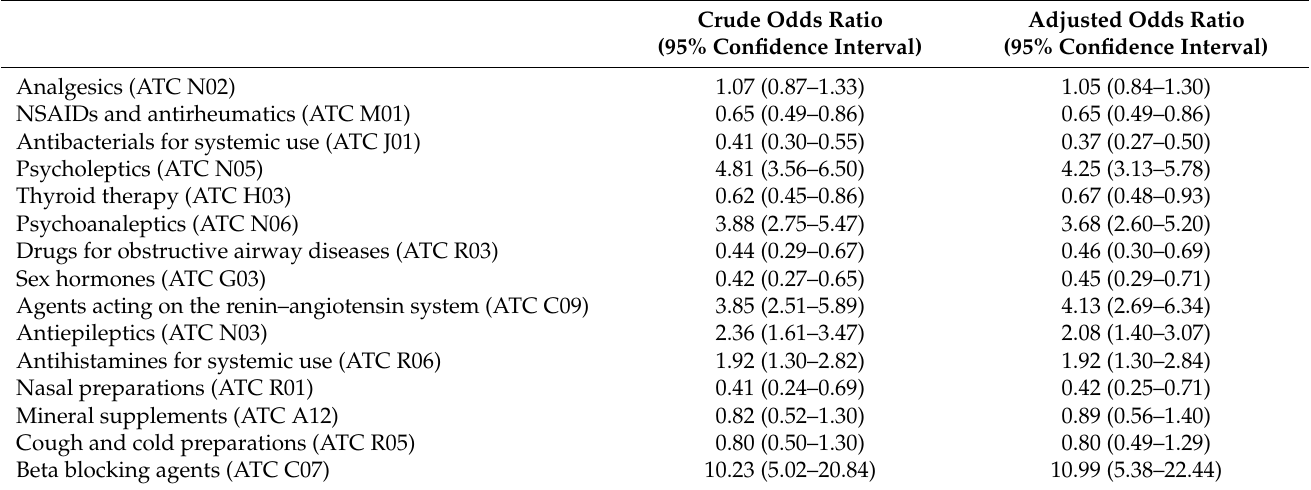
Table 4. Risk of ED visit or hospitalization according to the most frequently reported pharmacological drug